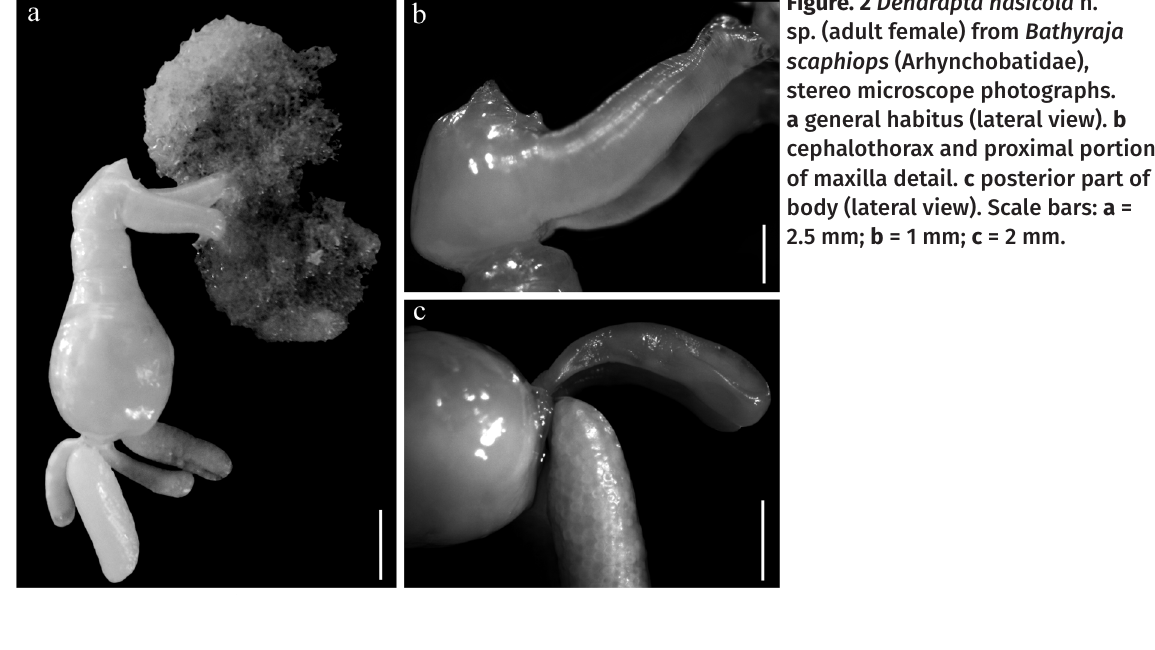
Figure. 2 Dendrapta nasicola n. sp. (adult female) from Bathyraja scaphiops